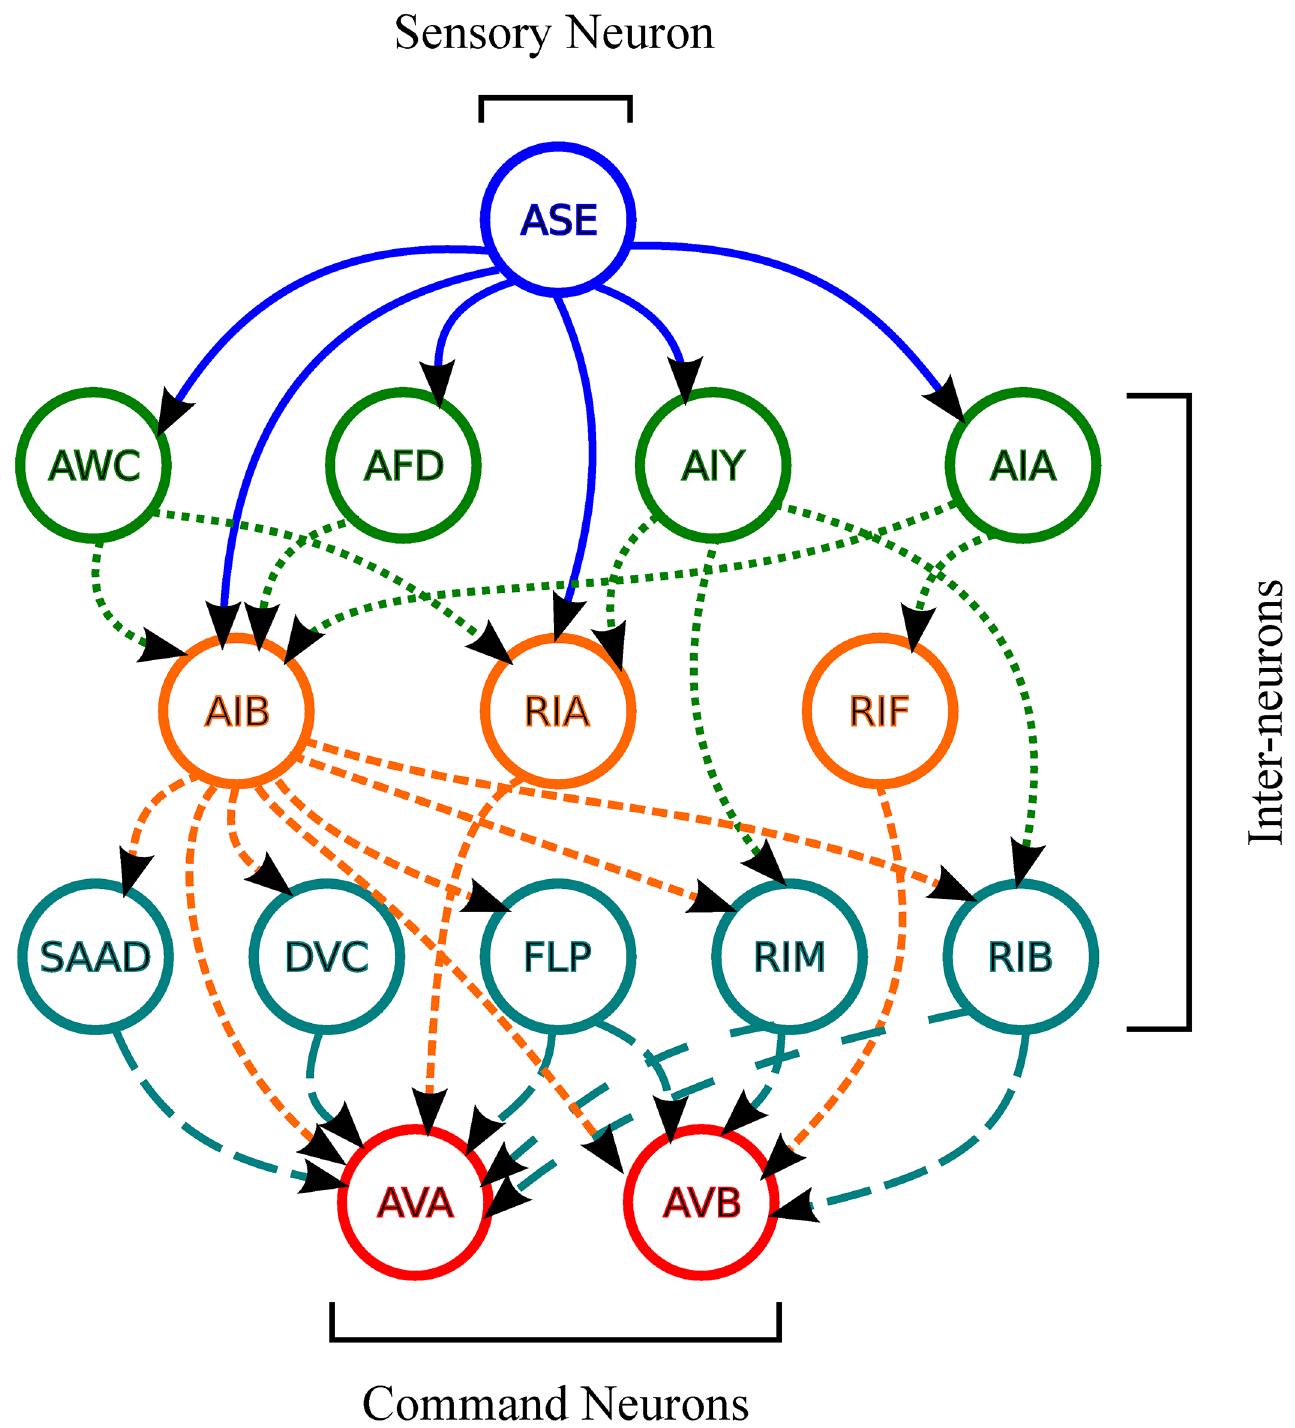
Fig 2. The chemotaxis neural network of C. elegans , based on [6, 7, 19]. The line type identifies the arcs leaving the neurons (vertices) of each layer. The solid line arcs leave the ASE sensory neuron; the dotted line arcs leave the AWC, AFD, AIY and AIA interneurons; the short dashed line arcs leave the AIB, RIA and RIF interneurons; and the dashed line arcs leave the SAAD, DVC, FLP, RIM and RIB interneurons.